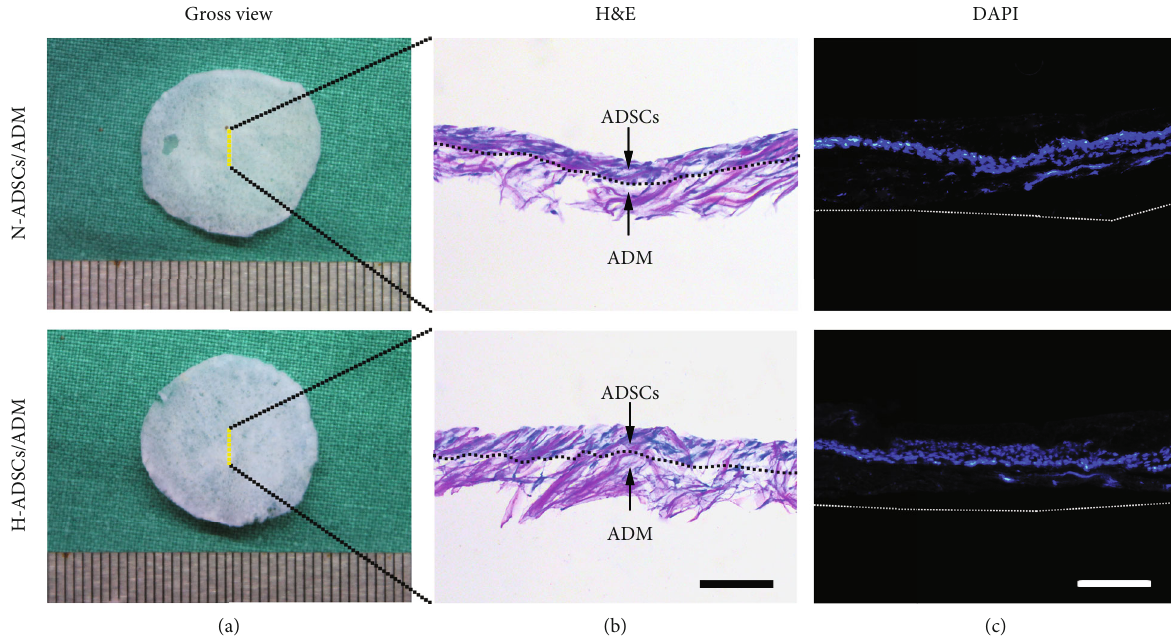
Figure 5: Morphological appearance of H-ADSCs/ADM. (a) Gross appearance, (b) histological morphology, and (c) DAPI images of the N- ADSCs/ADM membrane and the H-ADSCs/ADM membrane. The dotted line in (b) represents the boundary between the ADSCs and the ADM membrane. The dotted line represents the bottom of the ADM membrane. Bar = 100 mm.